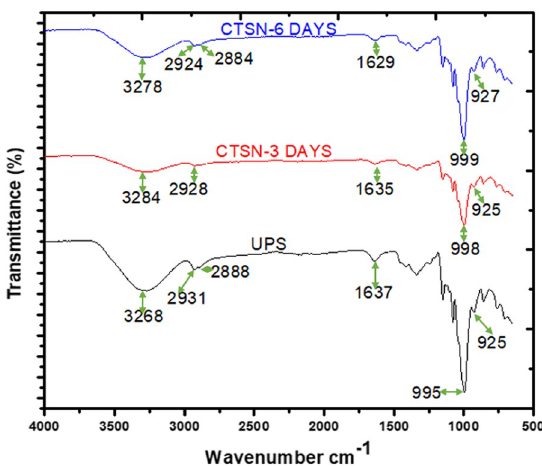
Fig. 7 The Raman spectra overlay of untreated starch and chemically treated starches. The comparison of the Raman spectrum of